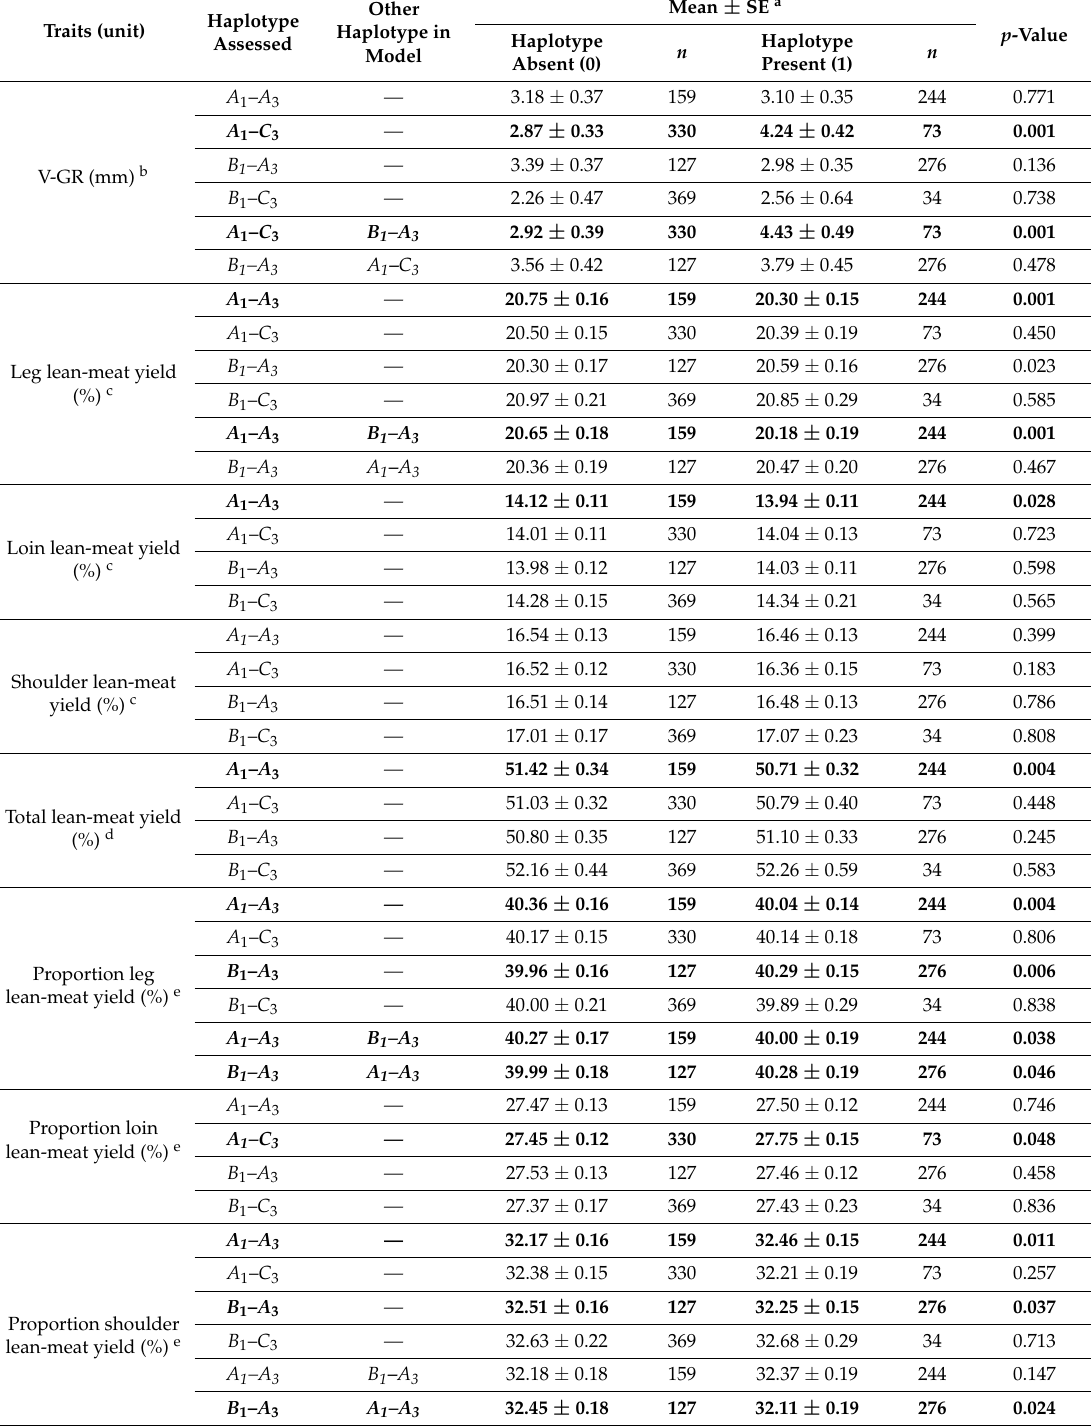
Table 2. Association of ovine ADIPOQ haplotypes with various carcass traits in NZ Romney sheep.